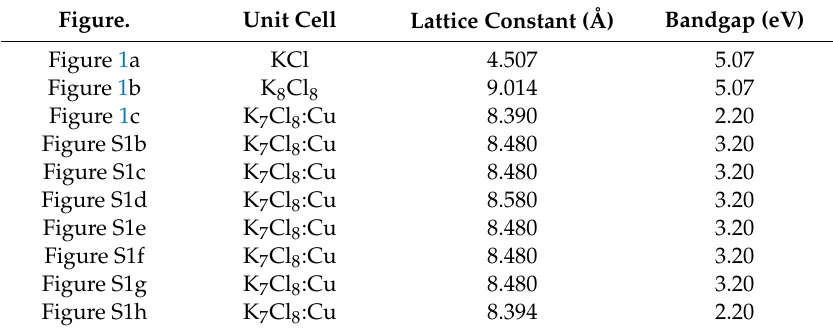
Table 2. Lattice constant and bandgap obtained in the DFT calculation for all systems where Cu dopant occupies substitutions sites replacing host K